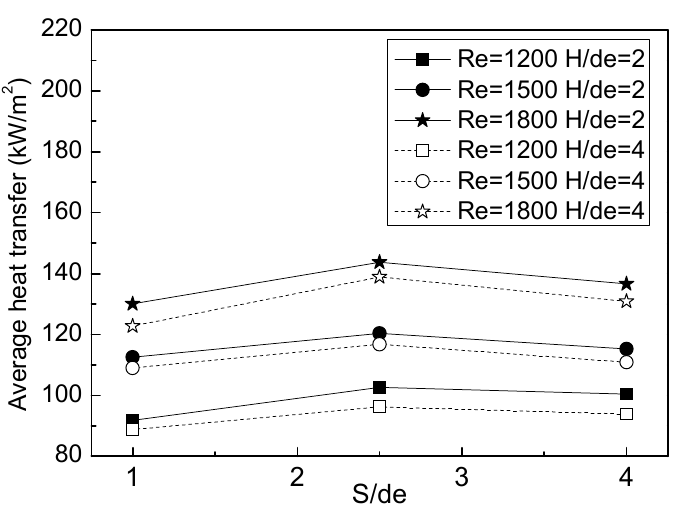
Figure 3. Area-averaged heat flux distribution of an LPG premixed flame array.